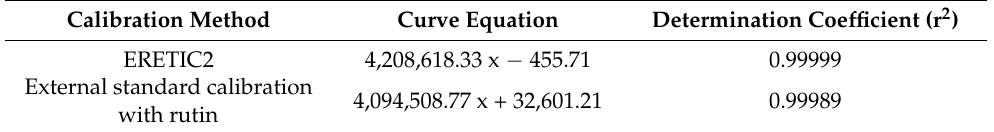
Table 3. Linearity results for ERETIC2 (based on the PULCON method) and external standard 216 methods.